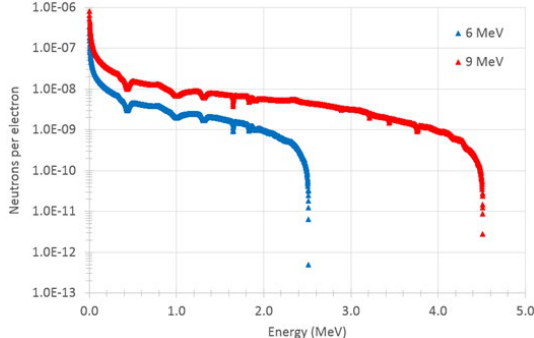
Fig. 6. Neutron activation measurement: production of photoneutrons.